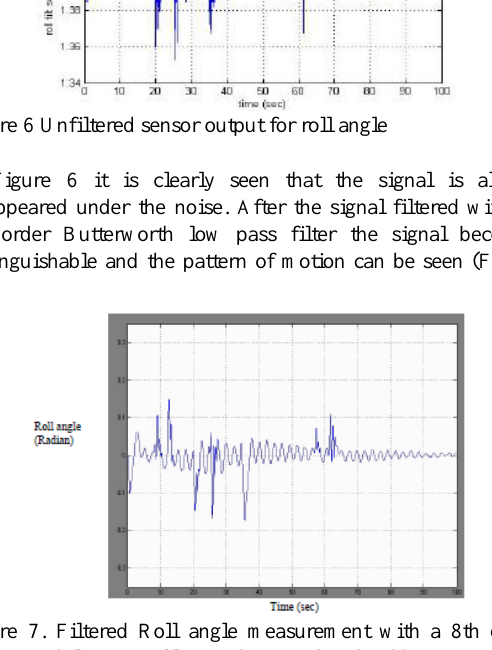
Fig 13. NGC Block diagram